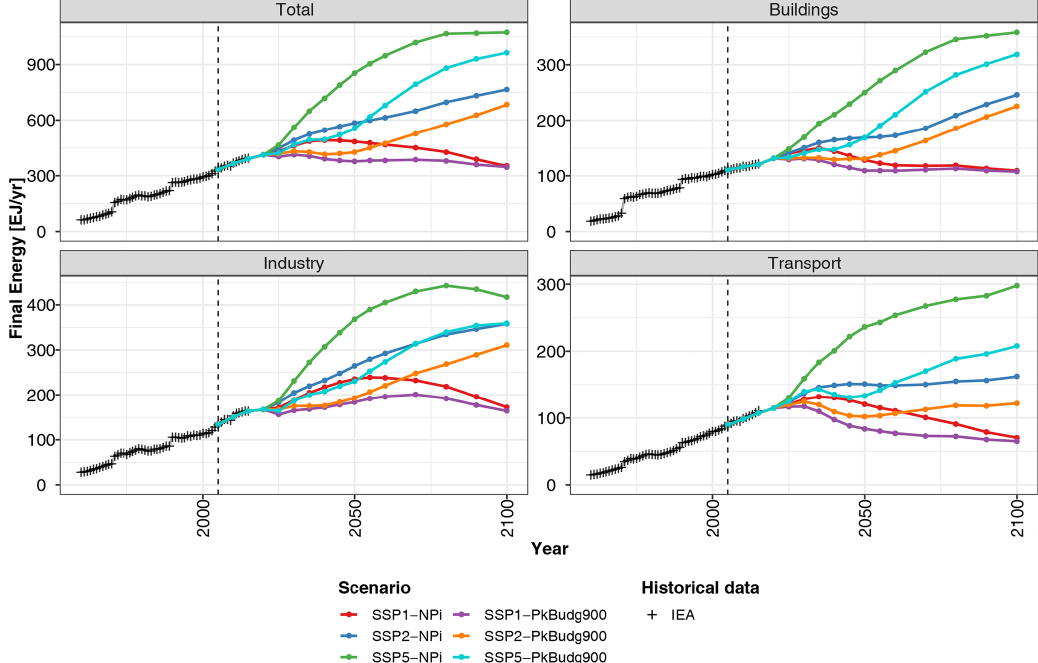
Figure A2. Global final energy for sectors for NPi and pkBudg900 (1.5 ◦ C) scenarios of SSP1, SSP2 and SSP5 compared to historical data from